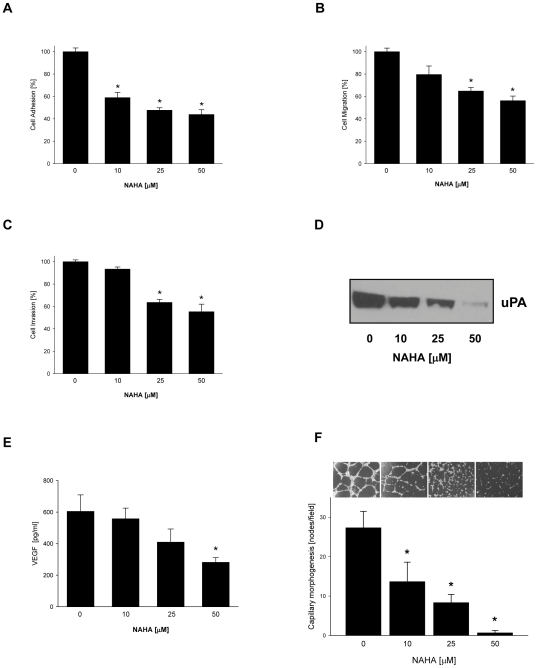
NAHA inhibits invasive behavior of breast cancer cells and capillary morphogenesis of endothelial cells.(A) Cell adhesion. MDA-MB-231 cells were treated with NAHA (0–50 µM) for 24 hours and cell adhesion to vitronectin determined as described in
Materials and Methods
. Each bar represents the mean ± SD of three experiments. * p<0.05. (B) Cell migration. Cell migration of MDA-MB-231 cells was determined after 5 hours of incubation in the presence of NAHA (0–50 µM), as described in
Materials and Methods
. Each bar represents the mean ± SD of three experiments. * p<0.05. (C) Cell invasion. Invasion of MDA-MB-231 cells through Matrigel was determined after 24 hours of incubation in the presence of NAHA (0–50 µM) as described in
Materials and Methods
. Each bar represents the mean ± SD of three experiments. * p<0.05. (D) uPA secretion. MDA-MB-231 cells were treated with NAHA (0–50 µM) for 24 hours, and the expression of uPA detected in conditioned media from the same amount of cells with anti-uPA antibody by Western blot analysis as described in
Materials and Methods
. The results are representative of three independent experiments. (E) MDA-MB-231 cells were treated with NAHA (0–50 µM) for 24 hours, media collected and secretion of VEGF determined as described in
Materials and Methods
. Each bar represents the mean ± SD of three experiments. * p<0.05. (F) HAECs were treated with NAHA (0–50 µM) for 16 hours. Capillary morphogenesis was determined as described in
Materials and Methods
. Each bar represents the mean ± SD of three experiments. * p<0.05.